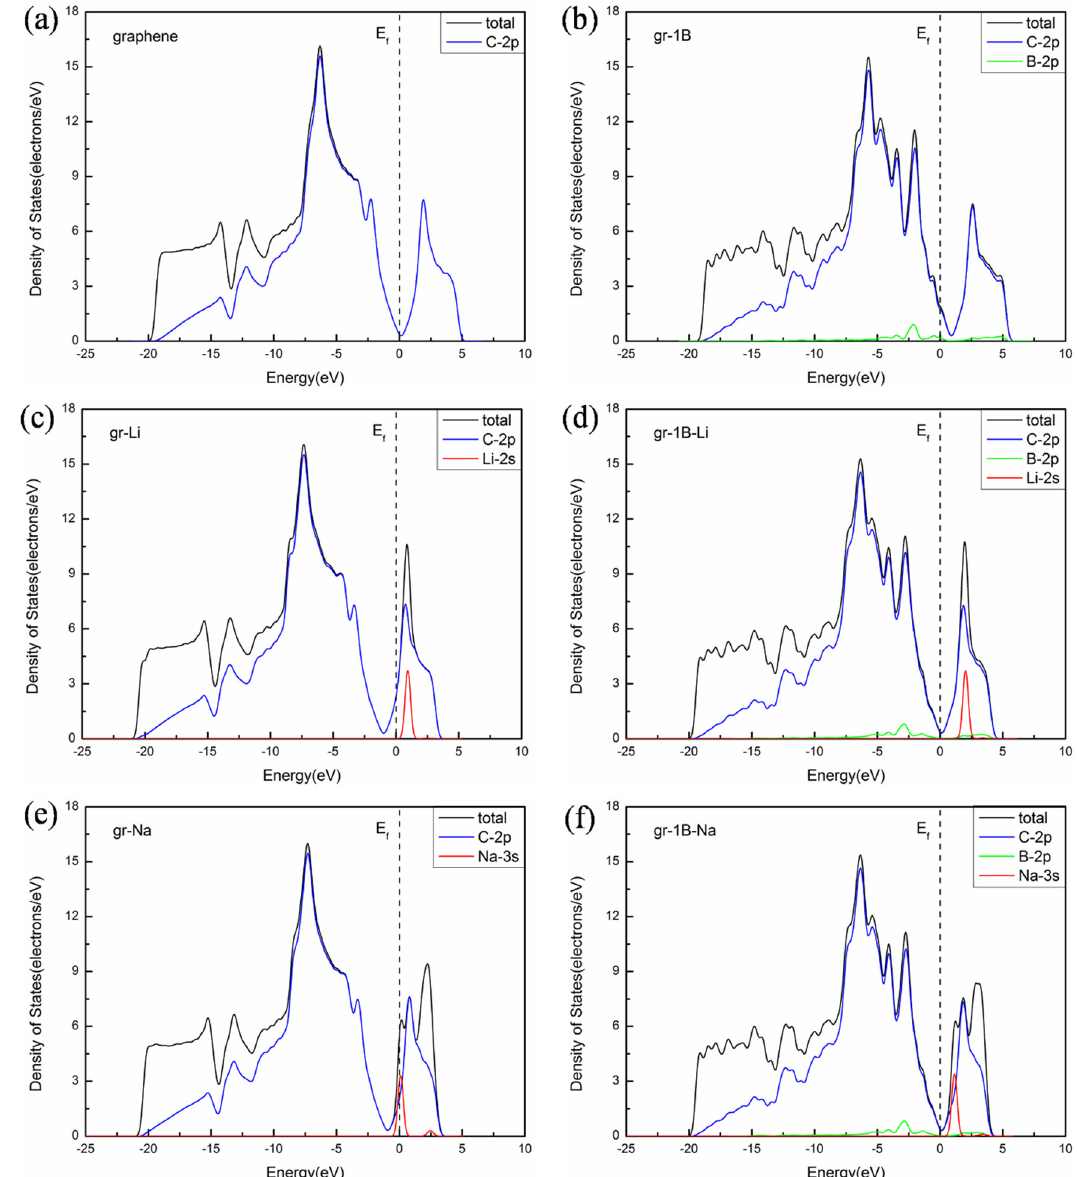
Figure 4. Density of states: ( a ) pristine graphene; ( b ) B-doped graphene; ( c ) pristine graphene with Li; ( d ) B-doped graphene with Li; ( e ) pristine graphene with Na; ( f ) B-doped graphene with Na.